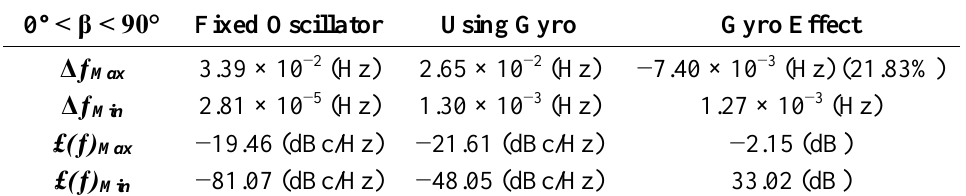
Table 4. Analysis of gyroscopic mounting efficiency for crystal with |φ| =